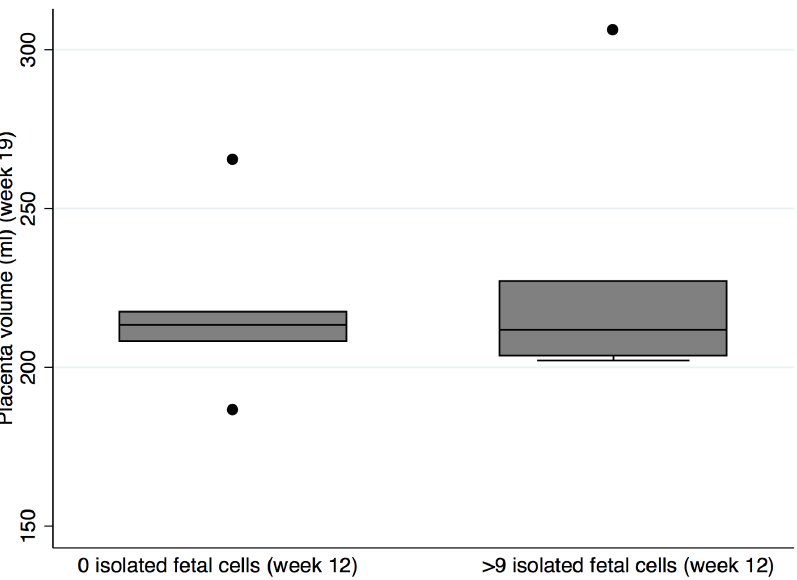
Figure 4. The estimated placenta size in week 19 in two groups with either a high number of isolated fetal cells (n=7) or a low number of isolated fetal cells (n=5) in 30 ml of maternal blood at a gestational age of 11–14 weeks, p= 0.94 (Mann-Whitney- Wilcoxon).